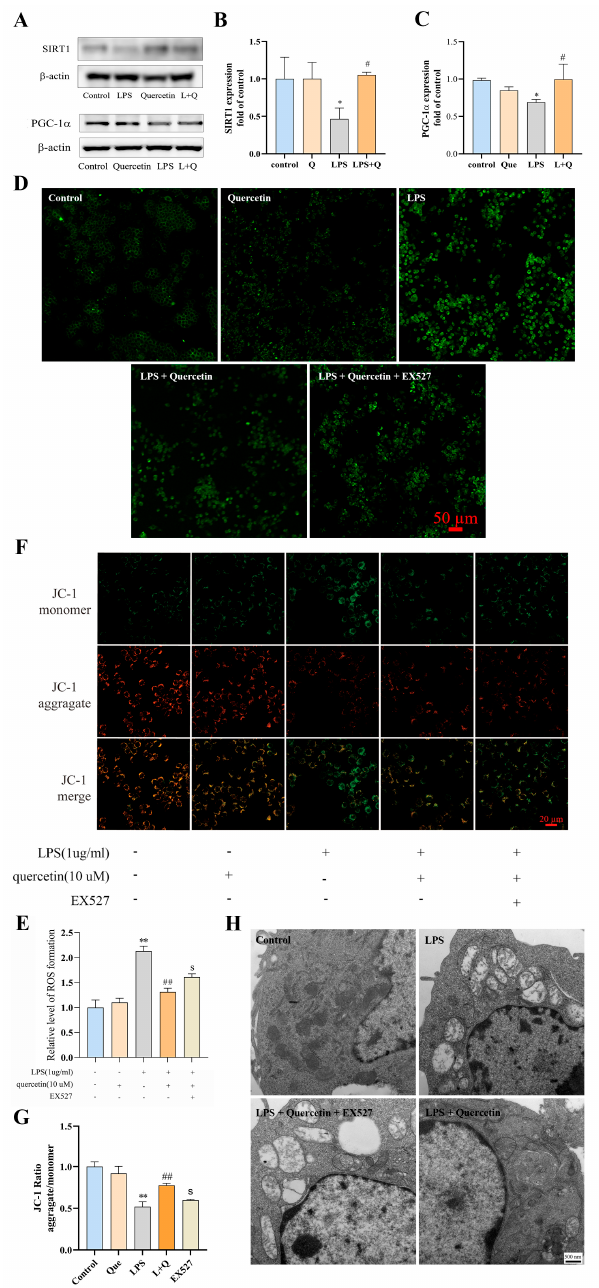
Figure 4. ( A – C ) Representative protein bands and the histograms of band intensity analysis of SIRT1 and PGC ‐ 1a in LPS ‐ induced RAW264.7 cells. ( D , E ) Images of DCF fluorescence intensity and